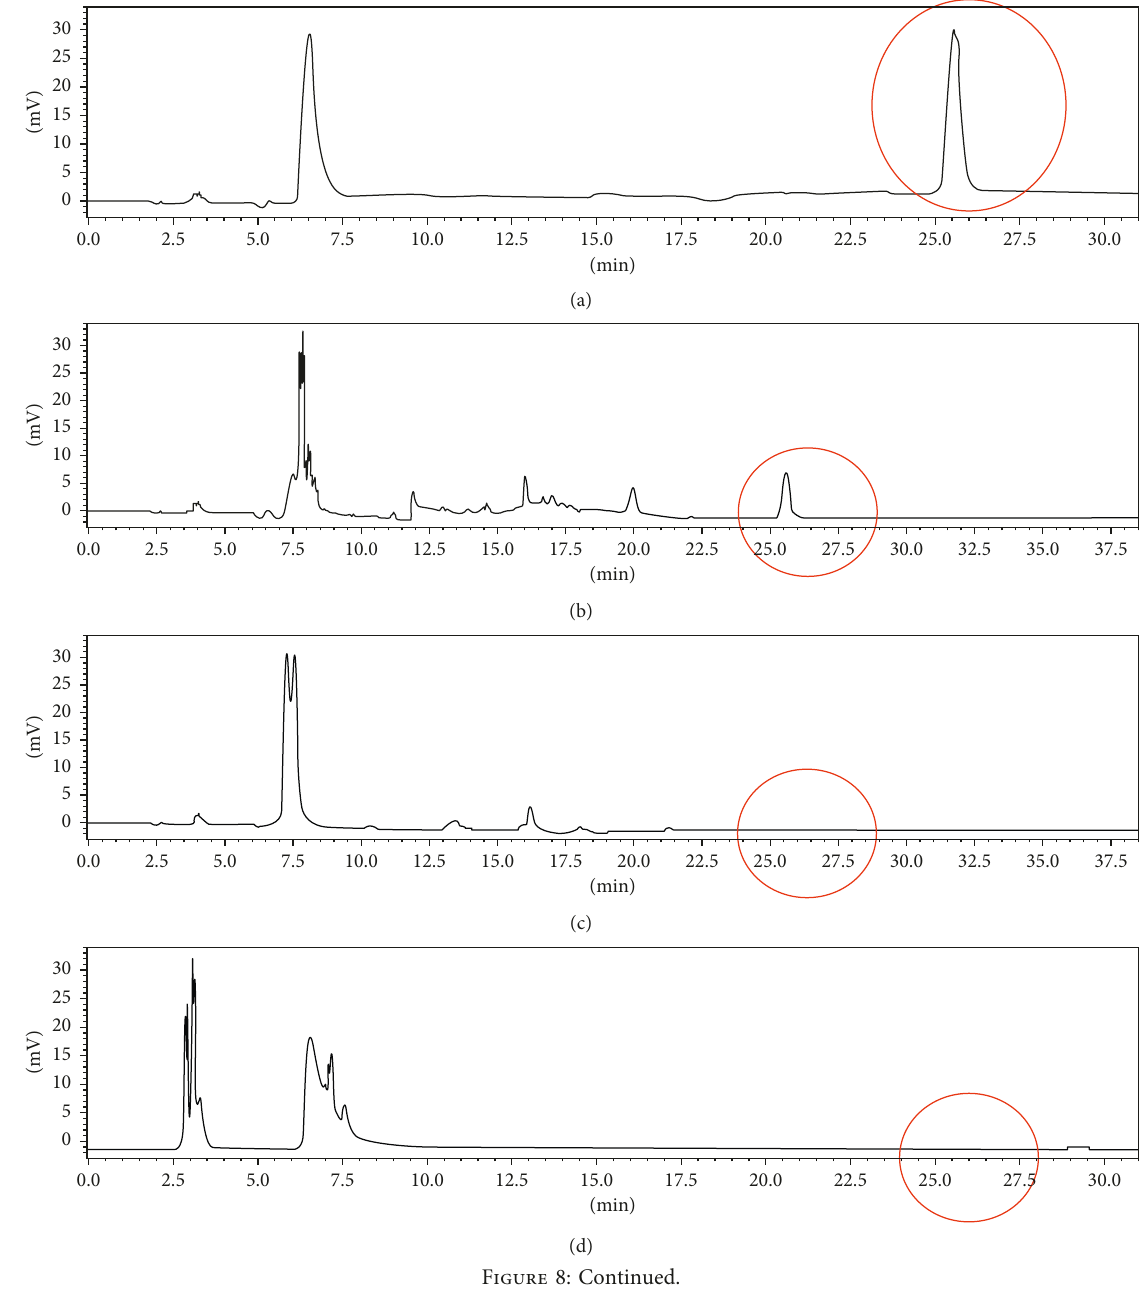
Figure 7: Escin standard curve at concentration 20mg/l to 100mg/l ( n ( p 0 . <